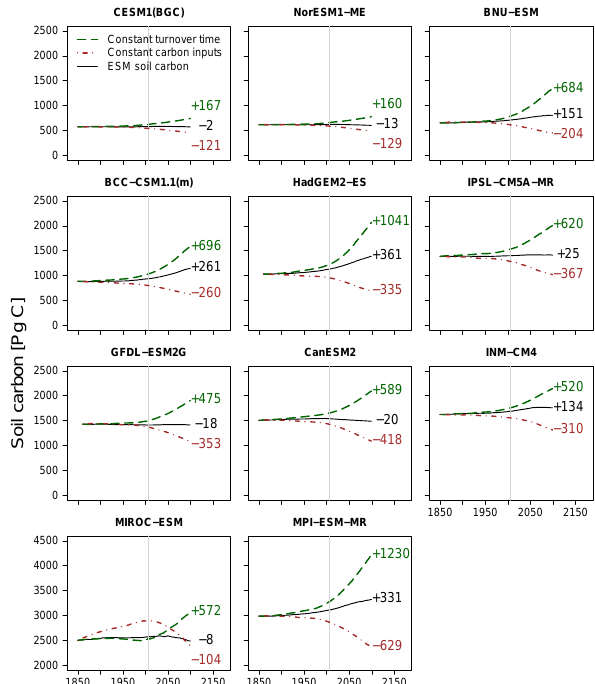
Fig. 5. Soil carbon over time (historical and RCP 8.5) under the “constant turnover time” and “constant carbon inputs” scenarios. The black solid line is the ESM-simulated global soil carbon stock with the net change from 1850 indicated in black text. The green dashed line is the soil carbon stock that would be predicted if turnover time were held constant at the 1850 value and soil in- puts were allowed to evolve as predicted by the ESM, with the net change indicated in green text. The red dotted line is the soil carbon stock that would be predicted if carbon inputs were held constant at 1850 levels and the turnover time were allowed to evolve as pre- dicted by the ESM, with the net change in red text. The vertical grey line at 2006 indicates where the historical experiment ends and the RCP 8.5 experiment